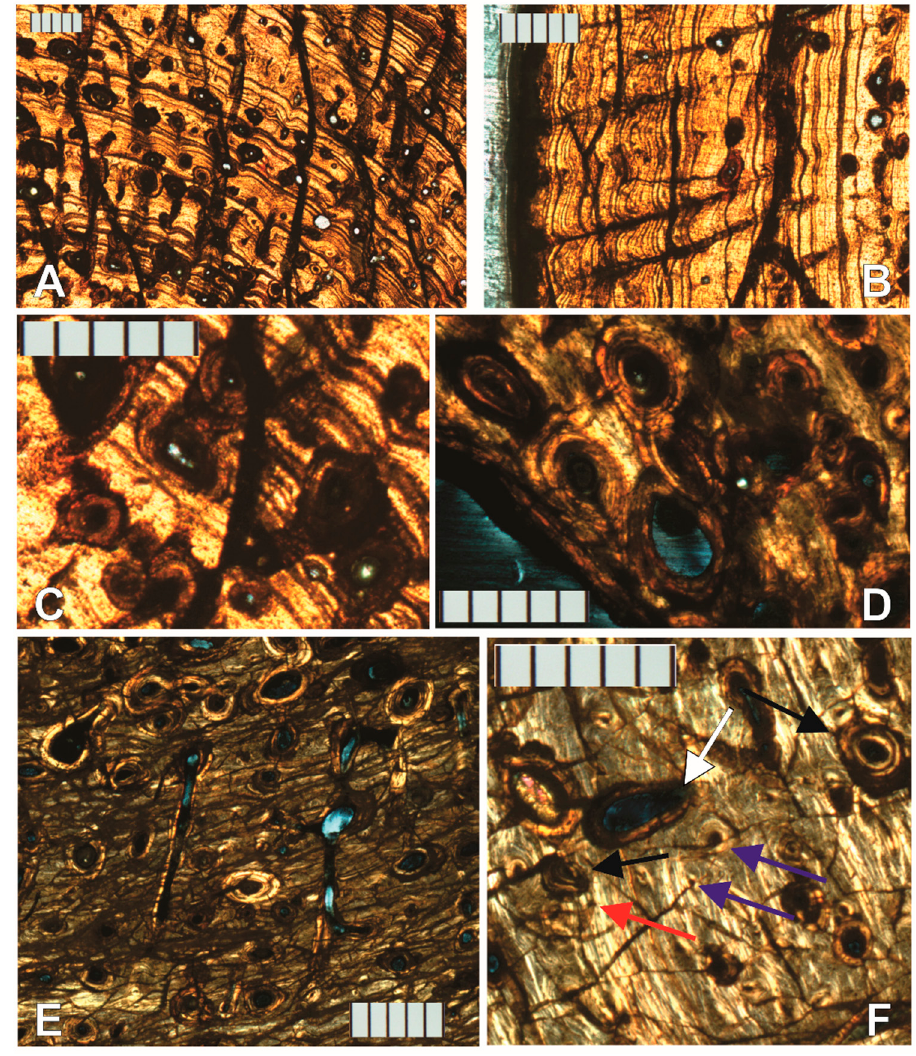
Figure 5. Histological structures in mid-diaphyseal thin sections of the bone of the left humerus of NJSM 23368, Hyposaurus rogersii . Images A through C were obtained from slide 3 under ordinary transmitted light. ( A ) Despite cracks in the section, which run from the top to the bottom of the image, growth cycles are readily visible in the lamellar-zonal bone. Longitudinally oriented secondary osteons arranged in circular rows dominate, but primary vascular canals and primary osteons are also common. Radial anastomoses from several of these vascular canals can be seen in this image as well; ( B ) Radial simple primary vascular canals near the periosteal margin; ( C ) First-, second-, and third- generation secondary osteons in the deep cortex; ( D ) First-, second-, and third-generation secondary osteons near the endosteal margin in slide 3, under CPL. The second-generation secondary osteon in the center of the image is flattened and appears elliptical rather than circular in the cross-section; ( E ) Some longitudinally oriented secondary osteons in slide 2 (imaged under CPL) anastomose radially, sometimes serially connecting more than 2 osteons and resembling radial vascularization. These are in line and parallel with each other, oriented obliquely across growth zones from the medullary cavity towards the periosteal margin (to the bottom of the image); ( F ) Primary vascular canals (red arrow), primary osteons (purple arrows), and secondary osteons (black arrow) in the cortex of slide 2 under CPL. The developing secondary osteons from erosion lacunae are also noteworthy (white arrow). All scale bars are 500 µ